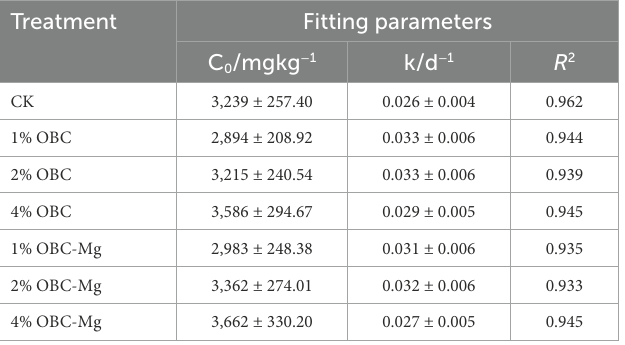
TABLE 4 Soil carbon mineralization kinetic parameters. Treatment Fitting